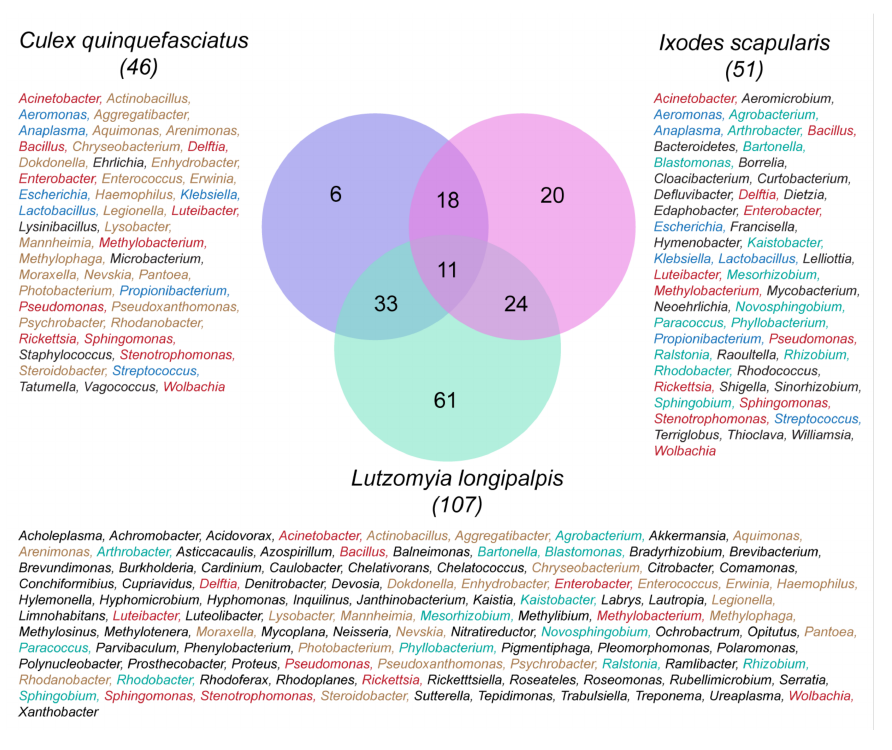
Figure 1. Venn diagram (iVENN program, created at RML) comparing the variety of genera of symbiotic bacteria and the extent to which they are shared among two insect and one tick species—representative species of vector insects and ticks: Culex quinquefasciatus, with 46 gen- era; Lutzyomia longipalpis , with 107 genera, and Ixodes scapularis, with 51 genera. C. quinquefasciatus has six unshared genera (shown in black font), but also shares 33 of its genera with L. longipalpis (brown font), 11 with both L. longipalpis and I. scapularis (red font) and 18 exclusively with I. scapularis (blue font). L. longipalpis has 61 unshared genera and 24 others shared exclusively with I. scapularis (turquoise font); I. scapularis, with 51 genera, shares 11 with both insects, as noted previously. Colors indicate level of sharing: red (shared by all three vectors); blue (shared between mosquito and tick); brown font (shared between mosquito and sand fly); turquoise (shared between tick and sand